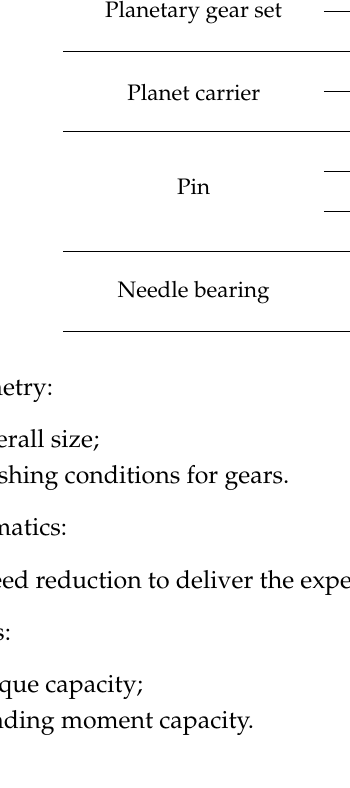
Table 3. Parts of the final reduction linked to the requirements through their subfunctions